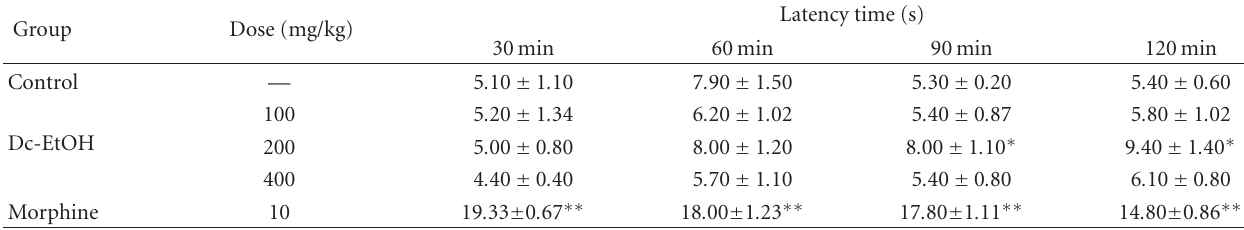
Table 3: E ff ect of Dc-EtOH on hot-plate test in mice.